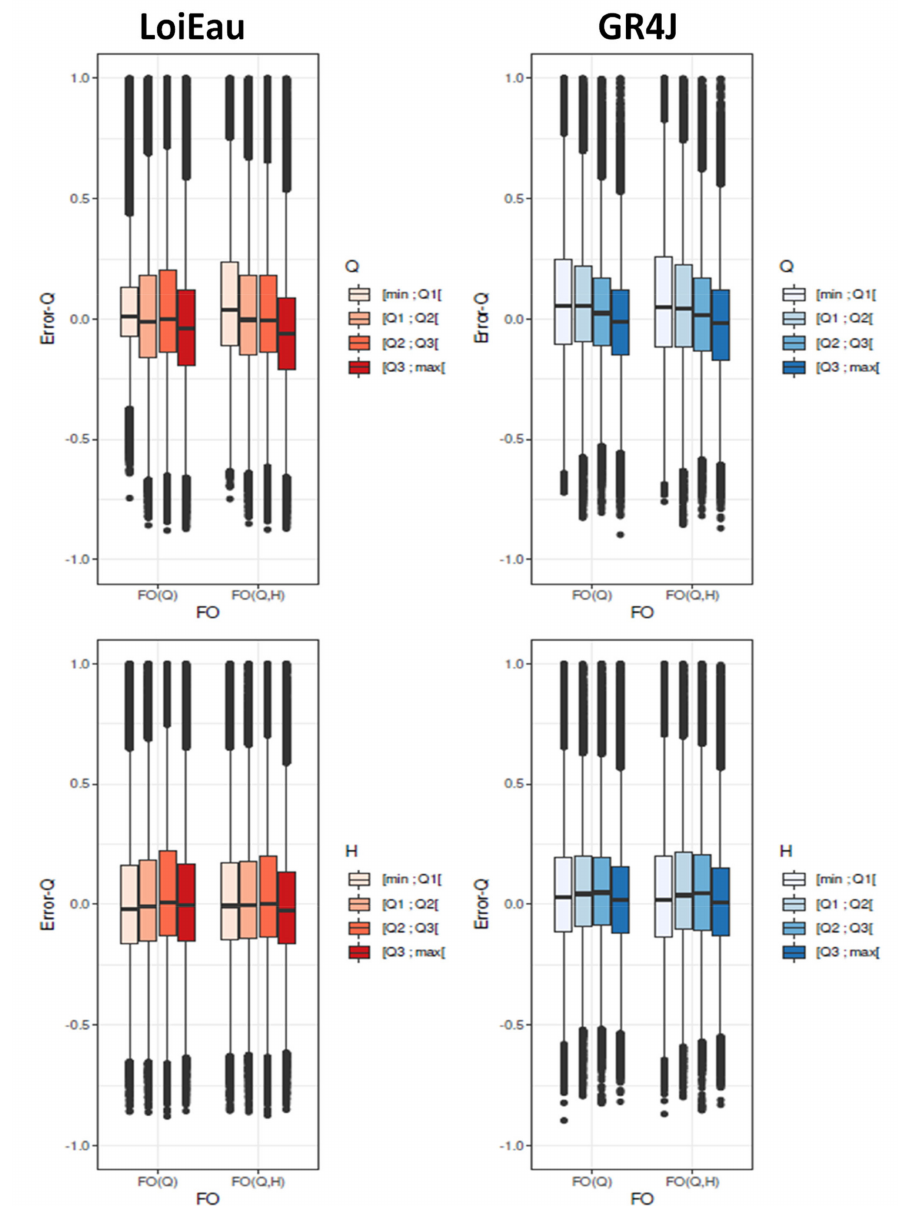
Figure 12. Distribution of modelling errors estimated for the calibration flow record for the GR- Loieau2J and GR4J models according to the two objective functions FO (Q, H) and FO (Q) and classified according to four classes of observed flow in mm/d and four classes of observed water table height in